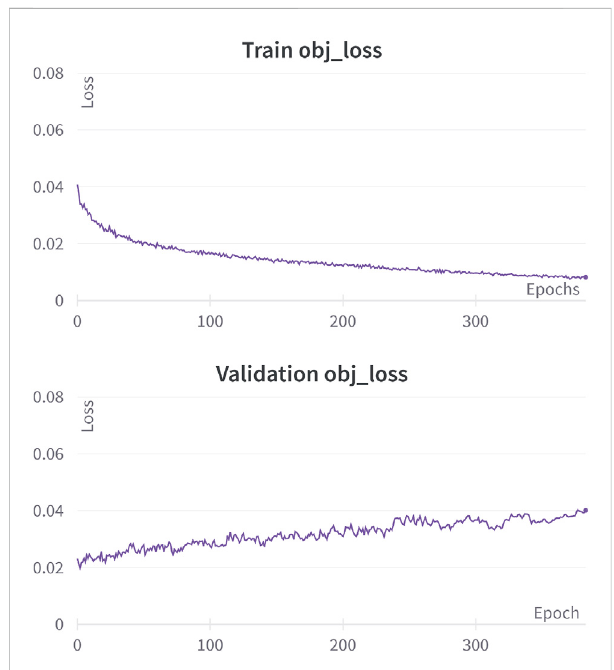
FIGURE 10 Training and validation performances in the object loss function during 31 epochs.